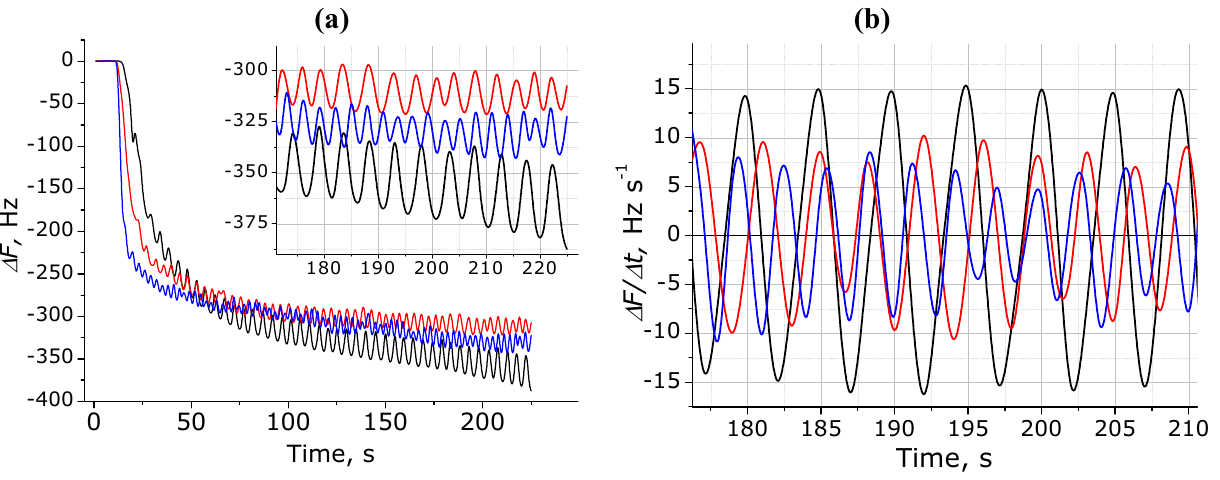
Figure 8. Respiration signals for three different participants obtained with the modified electrode (black line, R; red line, M; blue line, Y): (PDDA + /TSPP − ) 15 (a) absolute frequency change behavior and enlarged RP in inset; (b) RP obtained with differentiation of the QCM signal.